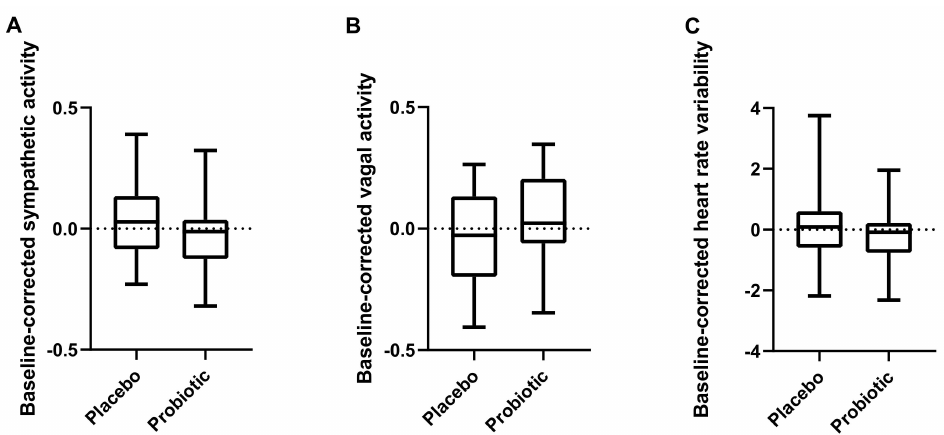
Figure 6. Autonomic nervous system activity during stress (evoked by the Stroop task). ( A ) sympa- thetic activity, ( B ) vagal activity, and ( C ) heart rate variability. Line presents median, box presents 25th and 75th percentile, and whiskers present minimum to maximum. Paired t -test, n =